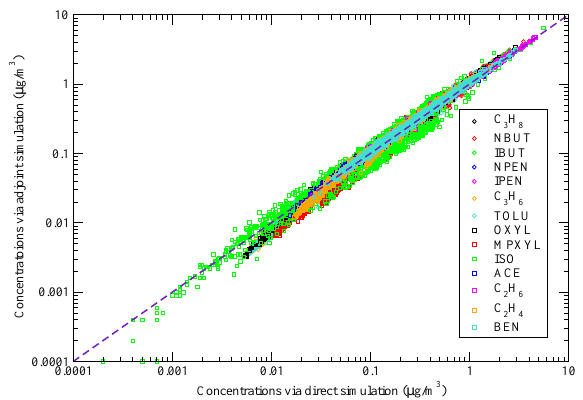
Fig. 2. Comparison of the source contribution to the observations